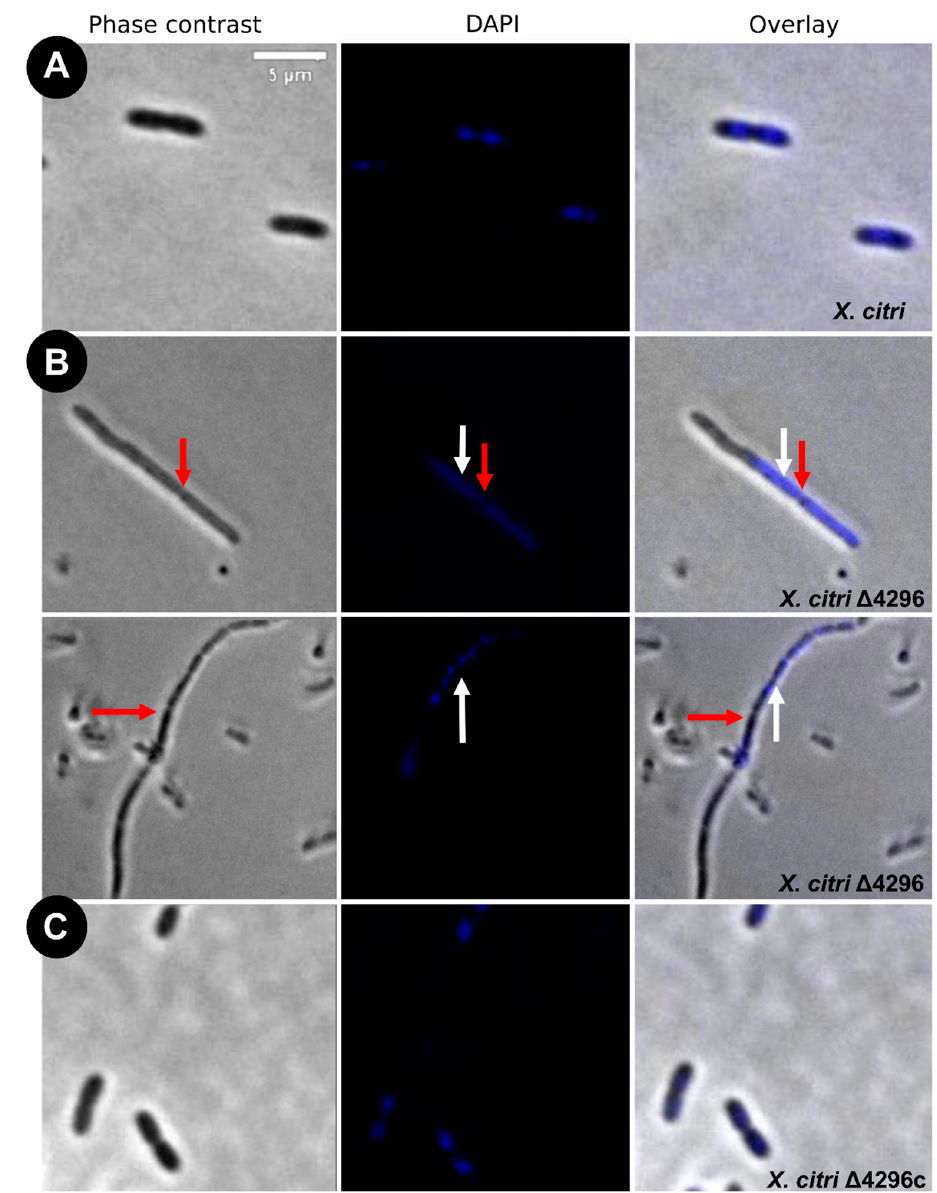
Figure 3. Morphological analysis and errors/aberrant nucleoid distribution of X. citri , ∆ 4296, and ∆ 4296c strains. Short filaments, chain phenotype, and errors/unusual nucleoid distribution were intensified without XAC4296. The figure shows microscopy phase contrast, DAPI, and overlay of the two filters for ( A ) X. citri WT; ( B ) Δ 4296, and ( C ) Δ 4296c (pMAJIIc-XAC4296) (magnification of 100×). White arrows indicate nucleoid distribution; red arrows indicate septum constriction (magnification of 100×)—scale = 5 µm. Table 2. Statistics of morphotypes and nucleoid distribution of cells cultivated in rich medium (NB).